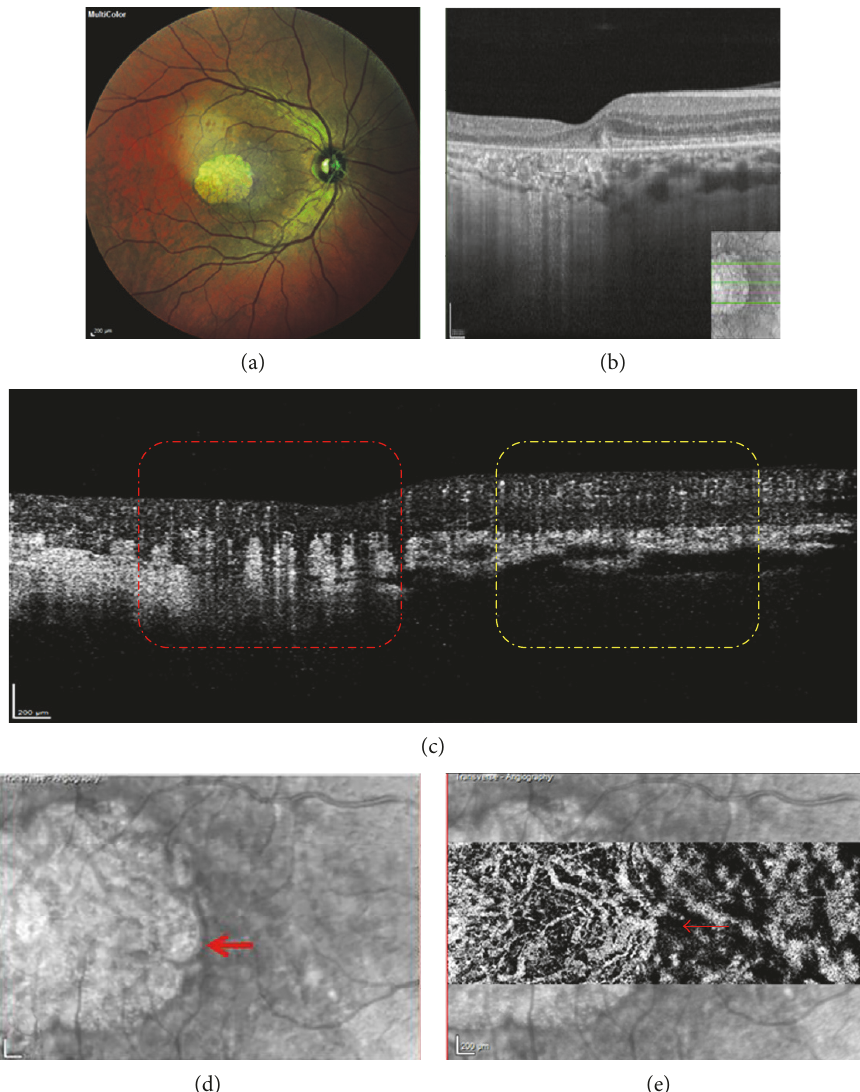
Figure 6: OCTA in a case of outerretinal atrophy.(a) Multicolourimageshowing a roundpenetrated hyperre fl ective regionin the macula indicating atrophy of the RPE. (b) SD-OCT showing enhanced choroid in the atrophic RPE area, as compared with the neighbouring normal region (inserted image indicates the direction of OCT scanning). (c) Corresponding cross-sectional OCTA con fi rms that the remaining fi ne vessels become obvious with a clear outline after neighbouring regional atrophy, in contrast with the relatively dark background (red dash-dotted box) when compared with normal tissues (yellow dash-dotted box). (d) Infrared image showing the boundary between atrophic and normal areas. (e) En face OCTA shows a hypointense halo beneath the normal RPE and continuing hyperre fl ective vascular signals due to the masked e ff ect (red arrows in (d) and (e)). OCTA: optical coherence tomography angiography; RPE: Retinal pigment epithelium; SD-OCT: spectral-domain optical coherence